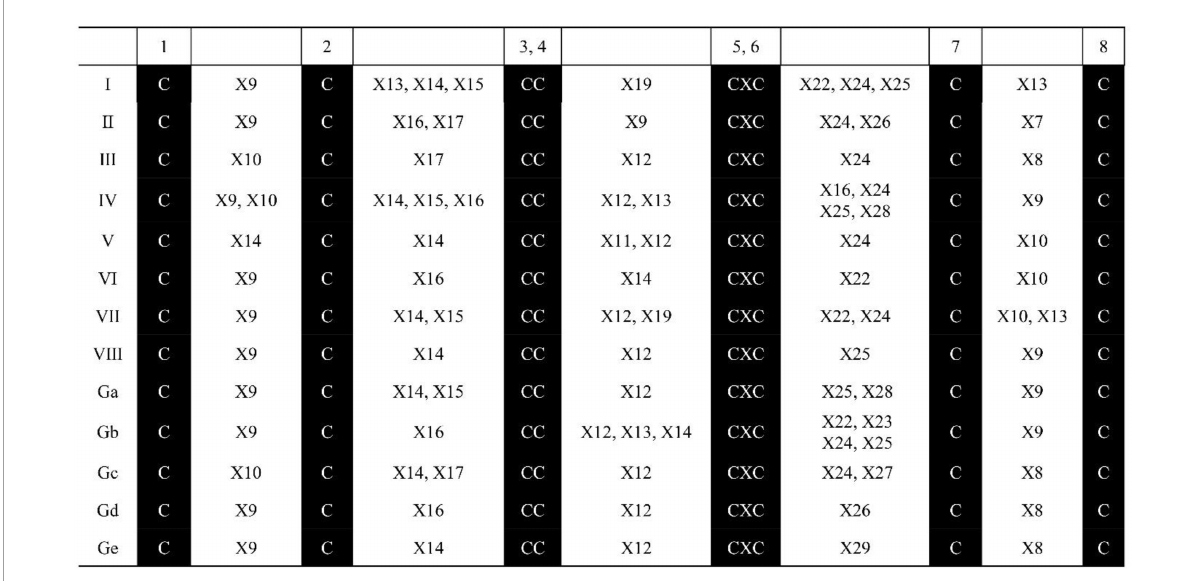
FIGURE1 Characteristics of ECM structure for nsLTP family genes identified in S. spontaneum AP85-441. “X” represents any amino acid, and the Arabic number beside “X” represents the number of amino acid